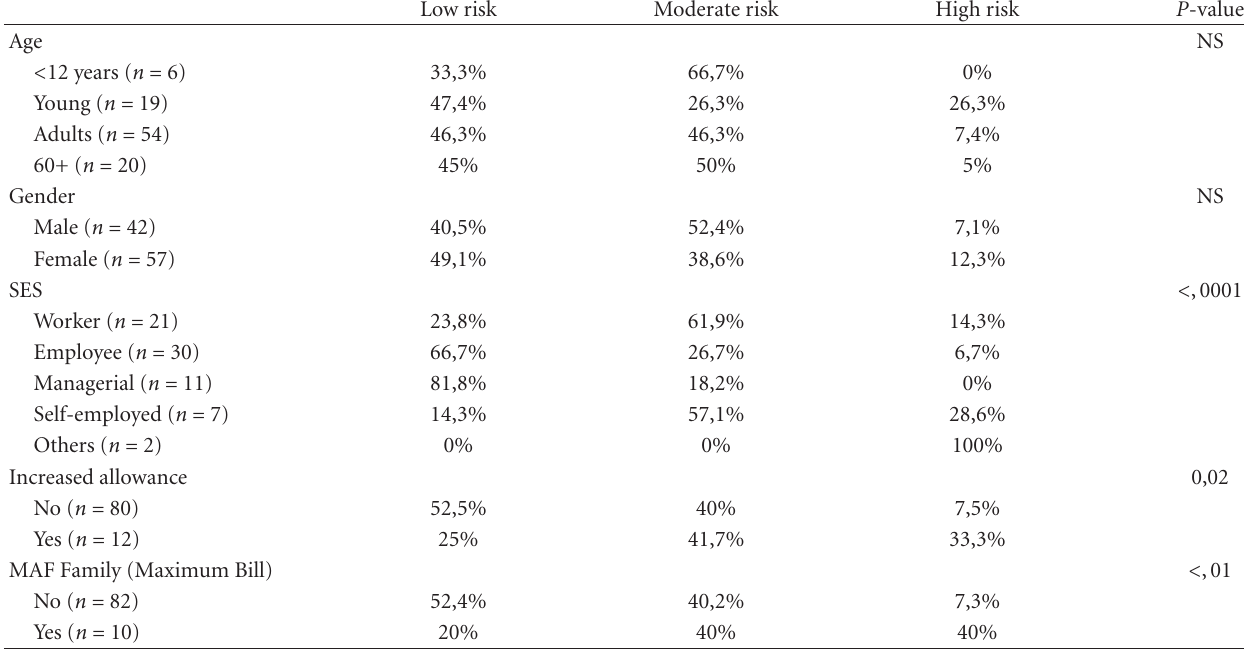
Table 1: Cross-tabulation for di ff erent sociodemographic variables and the three caries risk levels (Mann-Whitney U and Kruskal Wallis for 2 or more independent groups, resp.).